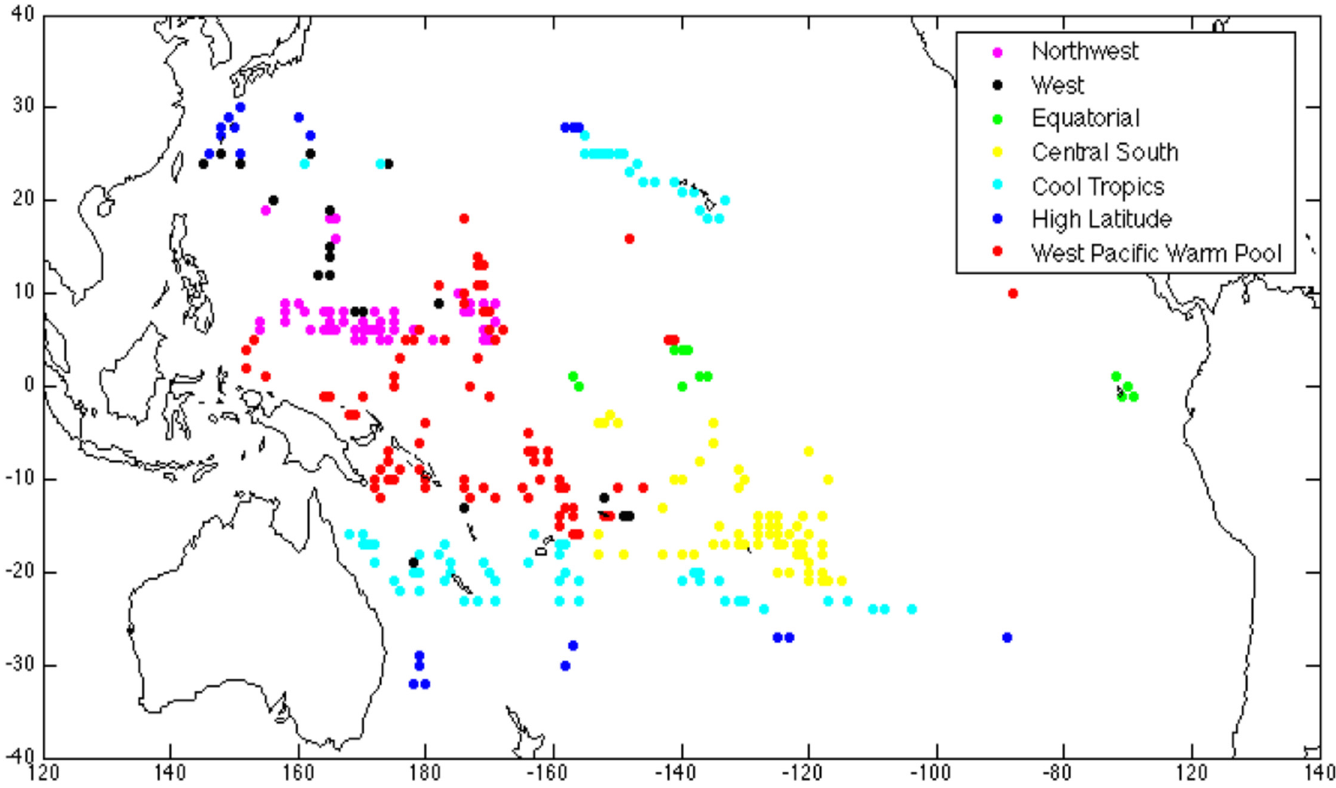
Fig 2. Map of Unique Physico-Chemical Coral Reef Habitats in the Remote Pacific. The seven unique physico-chemical coral reef habitats in the remote Pacific, mapped by color. Each colored circle identifies a remote coral reef location. The color indicates which habitat the coral reef falls into. Further description of these habitats can be found in Table 2. Copied with permission from Freeman et al. 2012 [17].